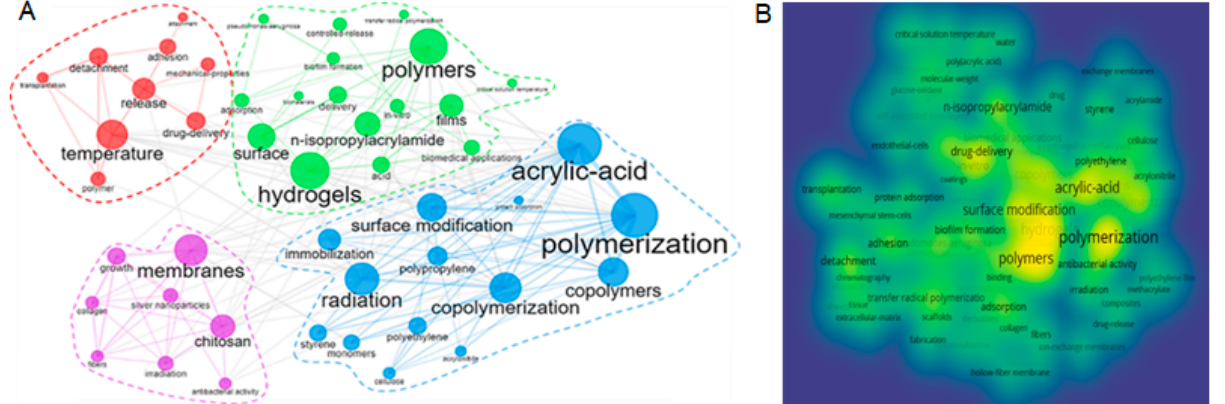
Figure 10. Keywords related to FPBMs obtained by RIGC: ( A ) combined network visualisation and ( B ) density map of co-occurrence. (Obtained from VOSViewer).